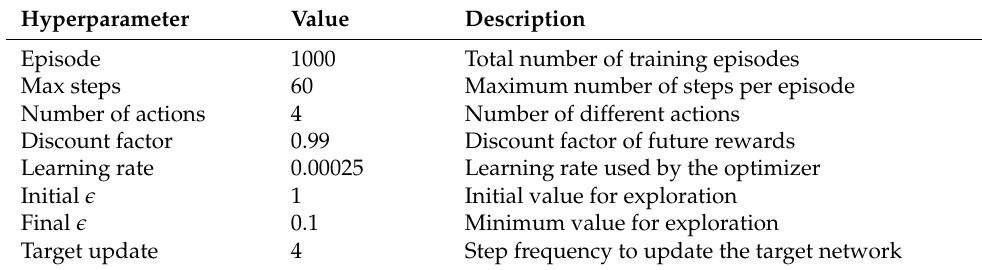
Table 1. Hyperparameters for the deep Q-learning